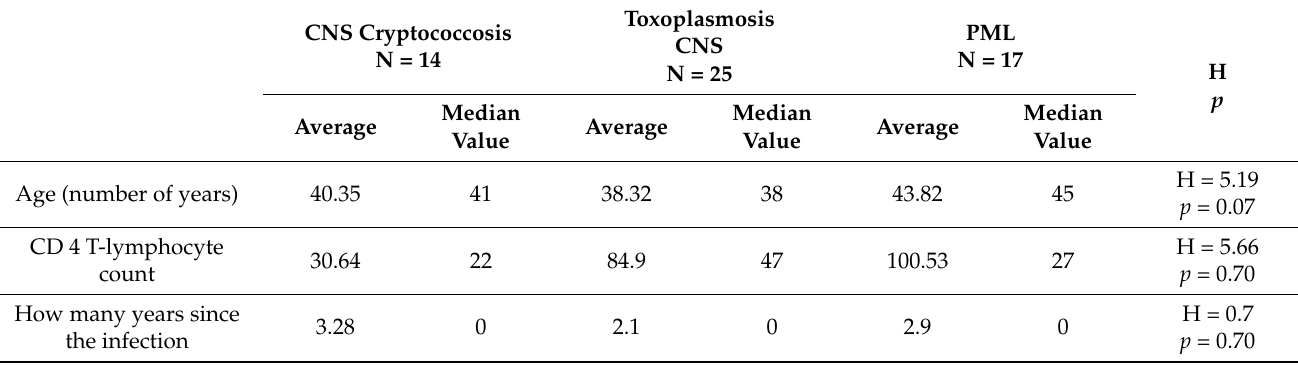
Table 8. Epidemiological data and the number of CD4 T-cells in particular subgroups of patients with diagnosed CNS